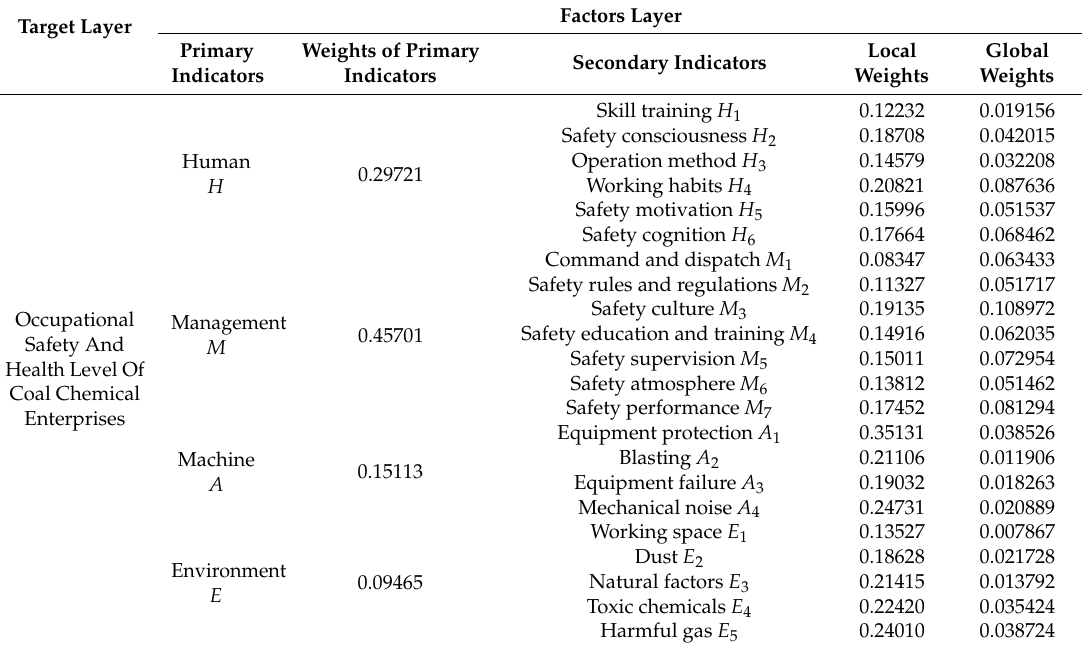
Table 3. OSH influencing factor weights